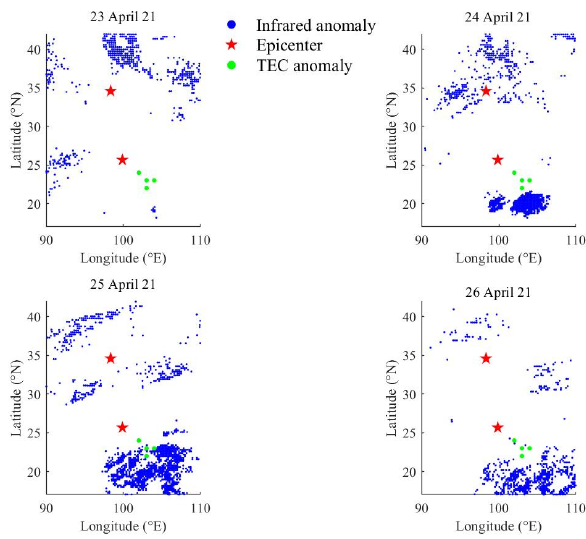
Figure 13. The infrared and TEC anomalies from 23 to 26 April 2021.